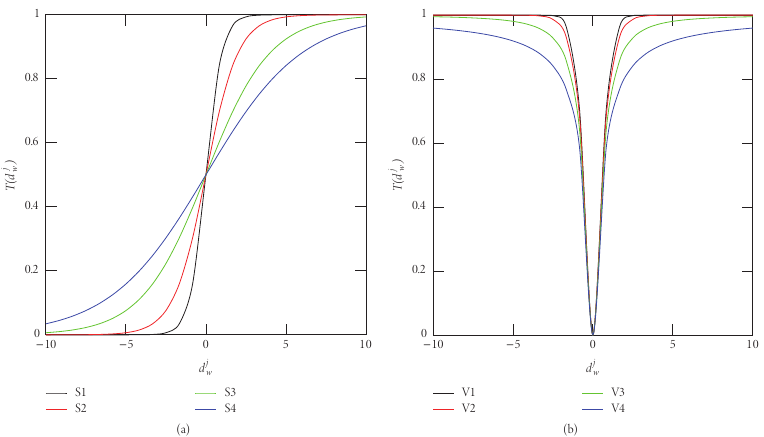
Figure 2. ( a ) S and ( b ) V transfer functions.